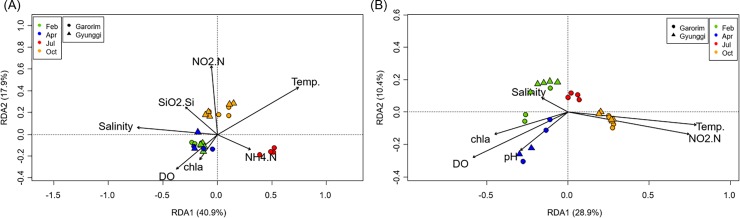
RDA models for archaeal (A. adj. R2 = 0.575, P = 0.001) and bacterial (B.adj.R2 = 0.410, P = 0.001) communities with selected significant environmental variables with minimum collinearity.